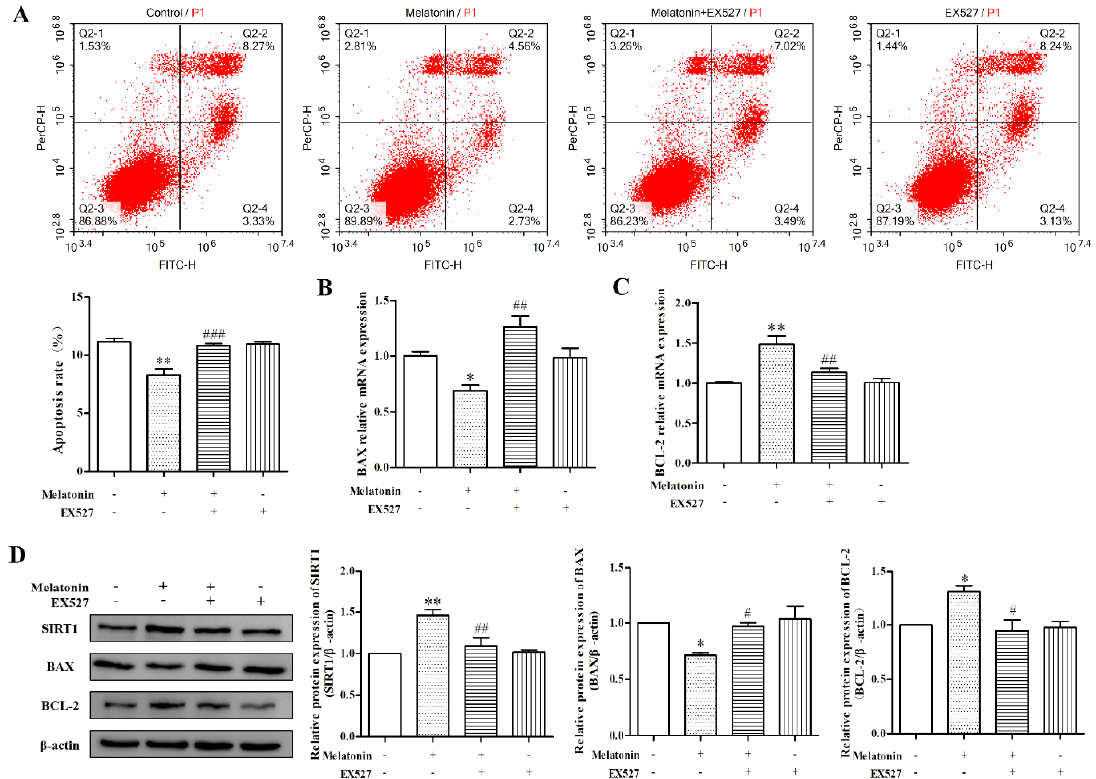
Figure 5. Effects of melatonin and EX527 on apoptosis of mouse Leydig cells. ( A ) The effects of melatonin and EX527 on apoptosis rate of mouse Leydig cells ( n = 3). The four quadrants in the figure represent dead cells (Q2-1), late-stage apoptotic cells (Q2-2), viable cells (Q2-3), and early-stage apoptotic cells (Q2-4). The apoptosis rate is the sum of values from Q2-2 and Q2-4. The relative mRNA expression levels of BAX ( B ) and BCL-2 ( C ) ( n = 3). ( D ) The relative protein expression levels of SIRT1, BAX, and BCL-2 were detected and analyzed ( n = 3). Values are shown as mean ± SEM. ** p < 0.01 or * p < 0.05 compared with the control group; ### p < 0.001, ## p < 0.01 or # p < 0.05 compared with melatonin-only treatment group.